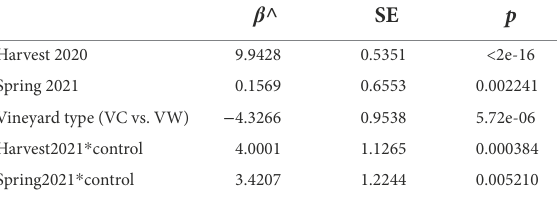
TABLE 1 Estimated coefficients ( β ^) for the fixed-effect terms in the model with the lowest AIC (3317.3) relating yeast abundance to tested